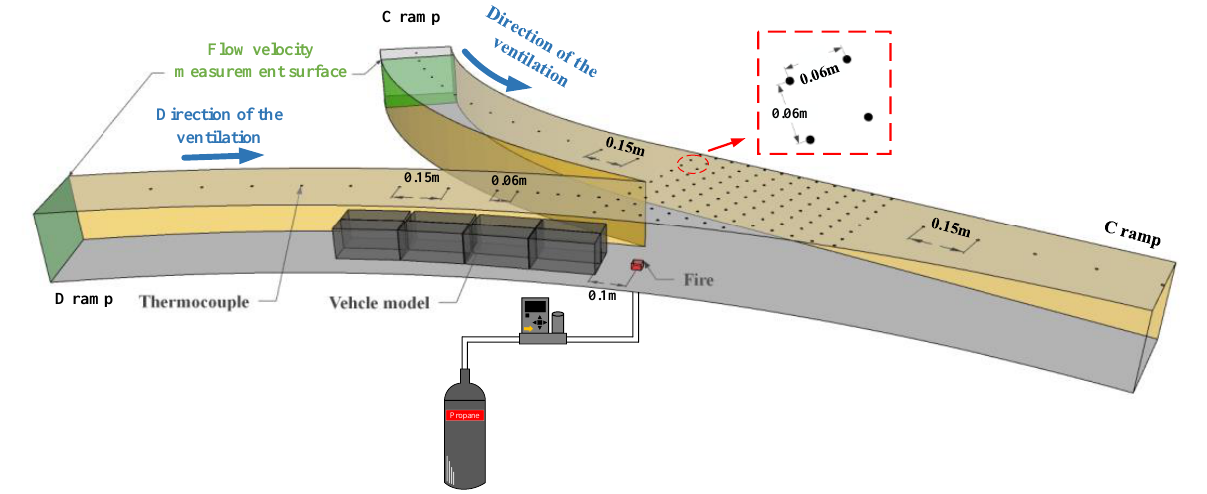
Figure 3. The layout of test points for the model-scale test.